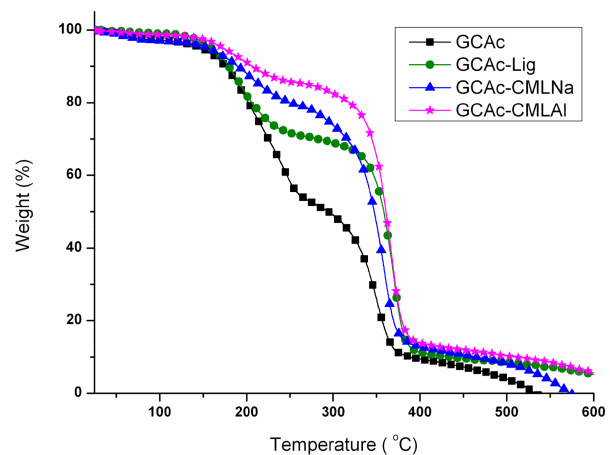
Figure 7. TG curves for the membranes of group II.